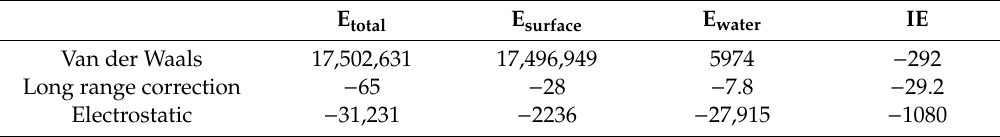
Table 3. IE between coal and water, kcal/mol.